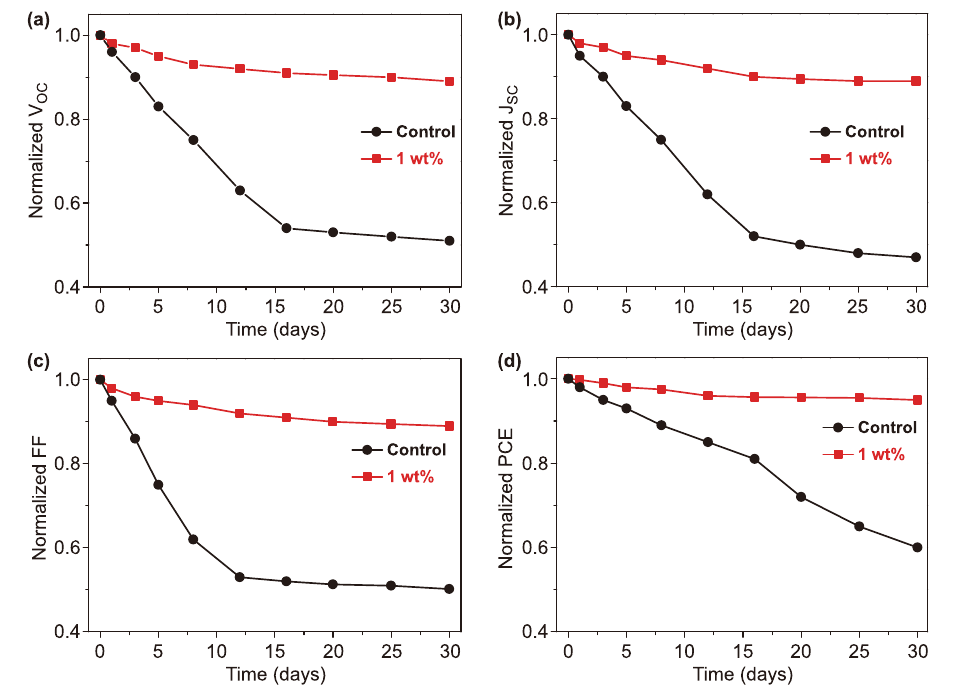
Fig. 6 Normalized a V OC , b J SC , c FF, and d PCE of the MAPbI 3 devices with and without PEA vs time. The devices are stored in a dark envi- ronment under ambient air with 30 ± 5% relative humidity